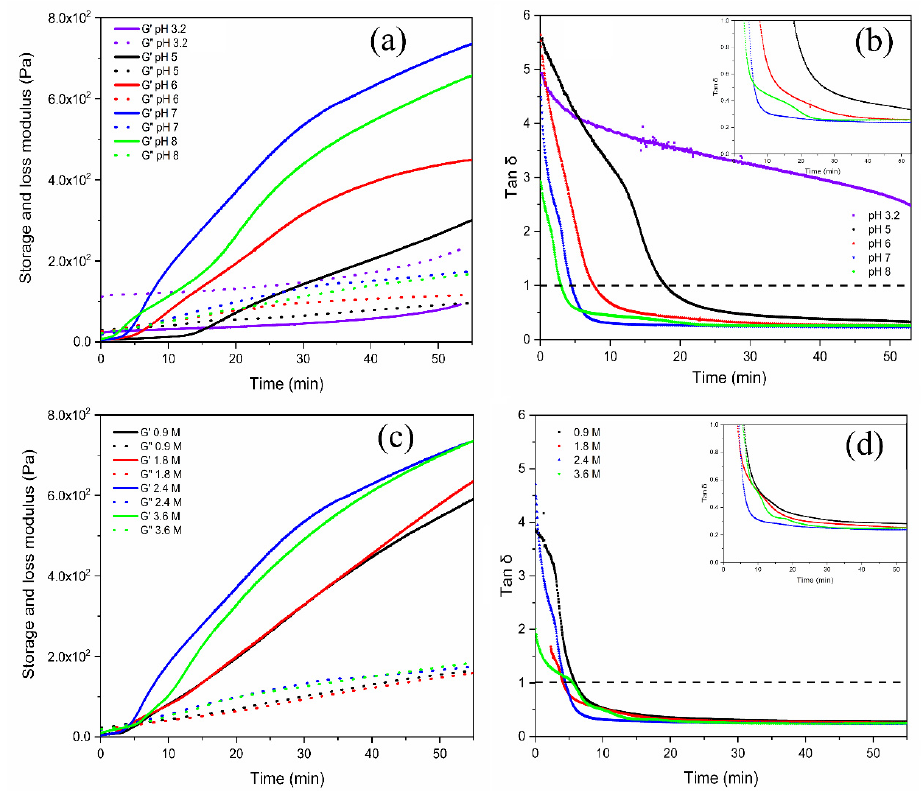
Figure 2. Time change of G’ and G” ( a ) and tan δ ( b ) for pectin (3% w / w ) with CaCl 2 = 2.4 M at various pHs ( c , d ) for 3% pectin solution at pH 7 with different calcium concentrations.